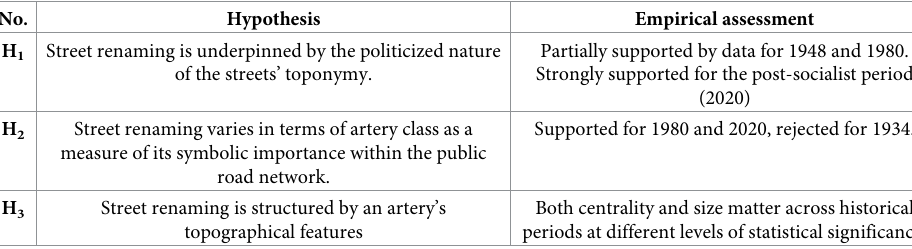
Table 6. Overview of the empirical assessment of research